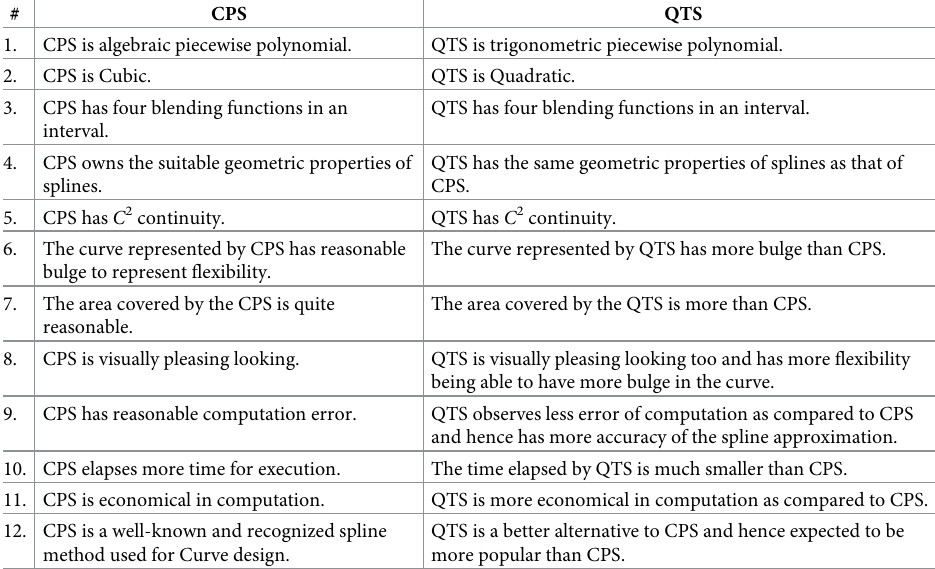
S1 Table. Table of data of objects. (PDF)